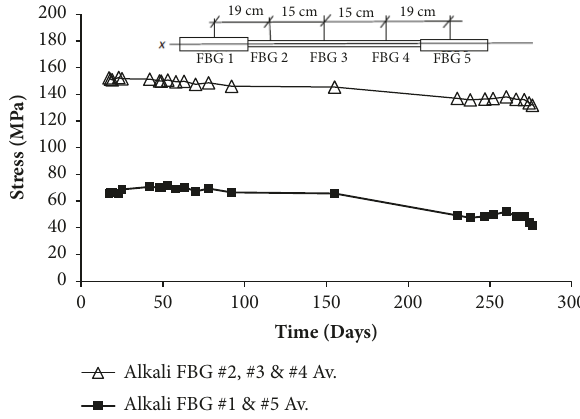
Figure 9: Stress versus time, average values